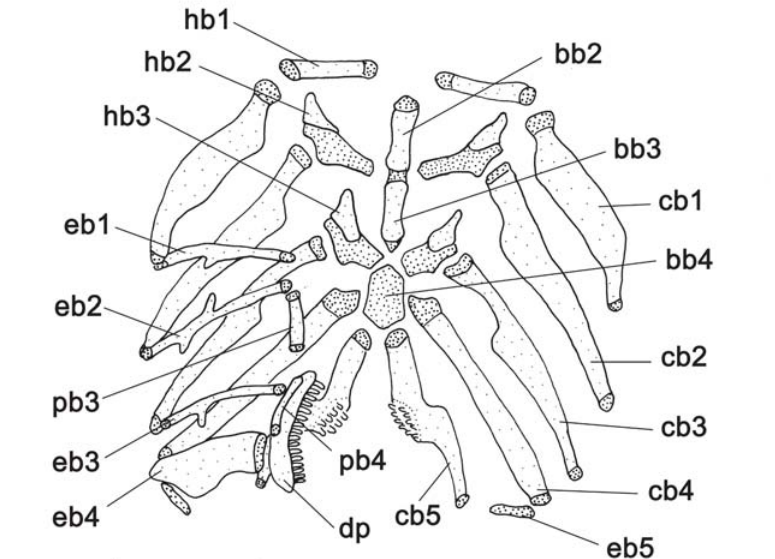
Fig. 5. Branchial skeleton of Ituglanis cahyensis , MNRJ 28405, paratype, 41.3 mm SL. Dorsal view (right dorsal elements and gill rakers not shown). Abbreviations: bb2 to bb4, basibranchial 2 to 4; cb1 to cb5, ceratobranchials 1 to 5; dp, dentigerous plate; eb1 to eb5, epibranchials 1 to 5; hb1 to hb3, hypobranchials 1 to 3; pb3 to pb4, pharyngobranchials 3 and 4. Scale bar = 1.0 mm. rows of dark brown blotches: an unpaired middle row runs along dorsal portion of trunk, followed by two paired rows along latero-dorsal sides of body. Latero-ventral parts of body becoming gradually less scattered towards ventral parts. Na- sal and maxillary barbels with chromatophores on their dorsal surface. Rictal barbel less pigmented on its proximal tip. Un- paired fins with light brown pigmentation concentrated on fin membrane. Pectoral fin with dark brown pigmentation limited to its basal part. Pelvic fins hyaline. Live coloration. Ground color pale yellow, mottled with gray- ish brown blotches, coalescing irregularly, and spots, forming longitudinal rows on trunk. Two longitudinal rows of coalesc- ing blotches on lateral sides of trunk, and one mid-dorsal row. Mid-dorsal row distinguished only on anterior portion of body, as blotches become progressively continue with lateral row close to dorsal-fin insertion. Head pale yellow to orange-yel- low with scattered grayish brown chromatophores. Ventral surface of head and belly white. Fins almost hyaline. (Fig. 6).